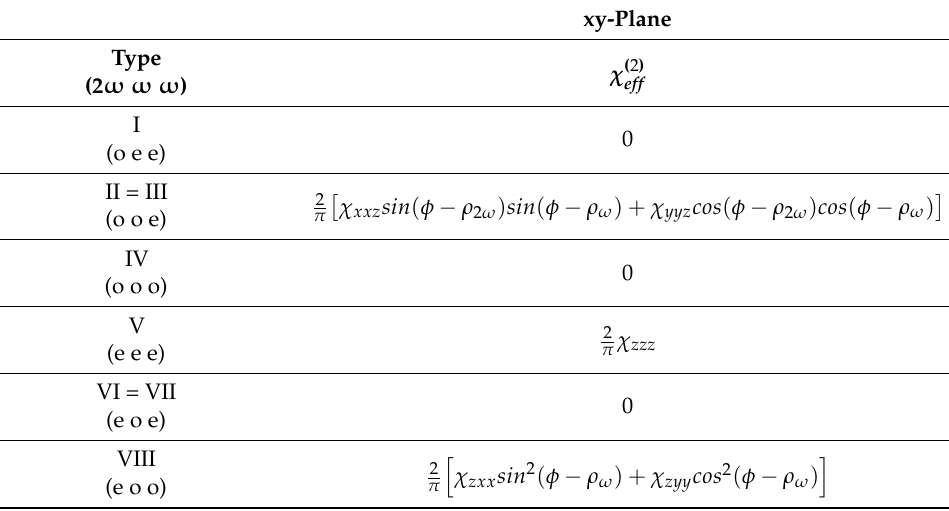
Table 3. Effective coefficient of AQPM SHG corresponding to all possible configurations of polariza- tion for AQPM SHG in the xy-plane of the crystal class mm2 and the positive biaxial optical class, which is the case of PPRKTP. The χ ijk ’s stand for the independent coefficients of the second-order electric susceptibility tensor at 2 ω . ρ ω and ρ 2 ω are the double refraction angles of the fundamental and second-harmonic waves, respectively. (o) and (e) stand for the ordinary and extraordinary polarizations, respectively.